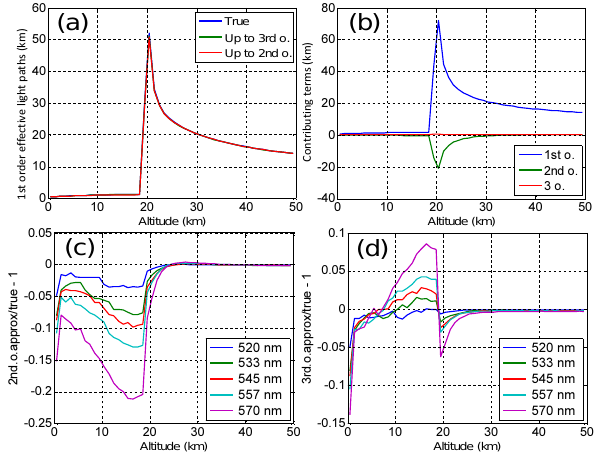
Figure 6. (a) Effective light paths at 545nm explicitly simulated by RTM for an absorption background (true) in comparison with first- order effective light paths approximated for this background from the effective light paths simulated for an atmosphere without ab- sorption. Calculations considering effective light paths up to either second or third order are performed. (b) Contributions from terms of different orders to the effective light paths in (a) . (c ,d) Relative differences between the approximated effective light paths consid- ering up to second- or third-order terms respectively and the explic- itly simulated effective light paths at the absorption background for different wavelengths in the mid-visible spectral